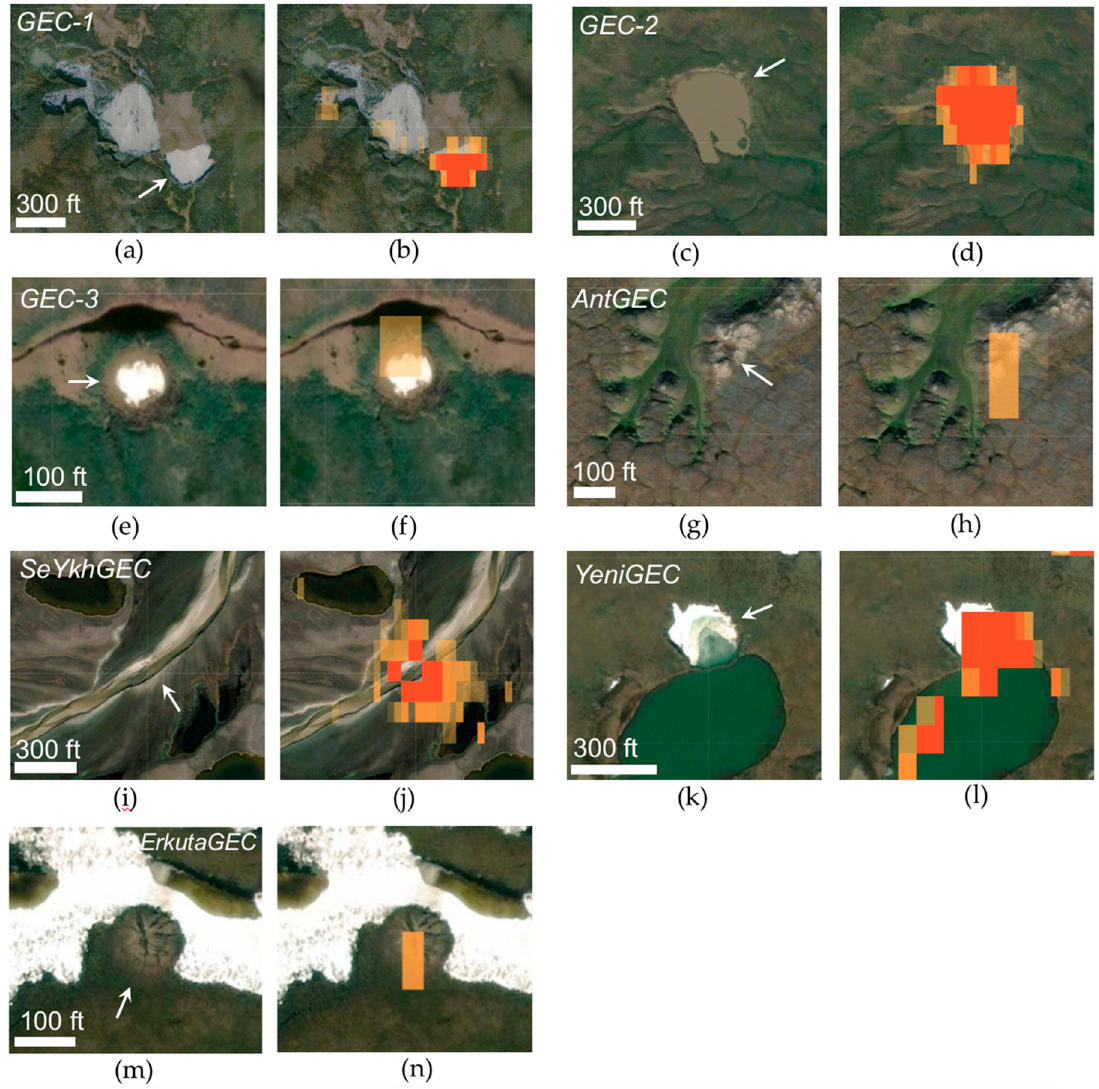
Figure A4. High-resolution satellite imagery of the seven gas emission craters (GECs) previously reported in the literature (Table 2), shown without change pixels (left panel) and with change pixels (right panel) for GEC-1 ( a , b ), GEC-2 ( c , d ), GEC-3 ( e , f ), AntGEC ( g , h ), SeYkhGEC ( i , j ), YeniGEC ( k , l ), and ErkutaGEC ( m , n ). Note: due to the difficulty of obtaining cloud-free, high-resolution imagery during the relatively brief period during which the characteristic crater stage of GEC evolution, most images show the GECs prior to (e.g., ErkutaGEC) or after (e.g., YeniGEC) their formation. Imagery © 2020, DigitalGlobe.